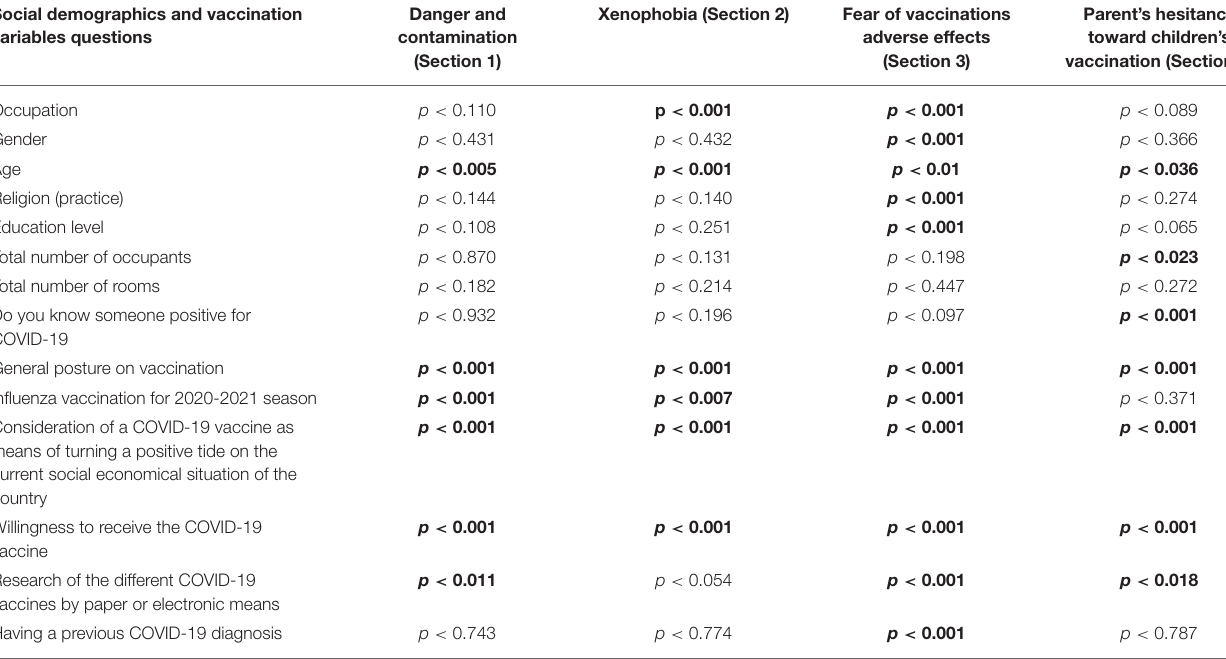
TABLE 3 | Statistical correlation ( p -values) for social demographics and coronavirus disease 2019 (COVID-19)-related questions and sections